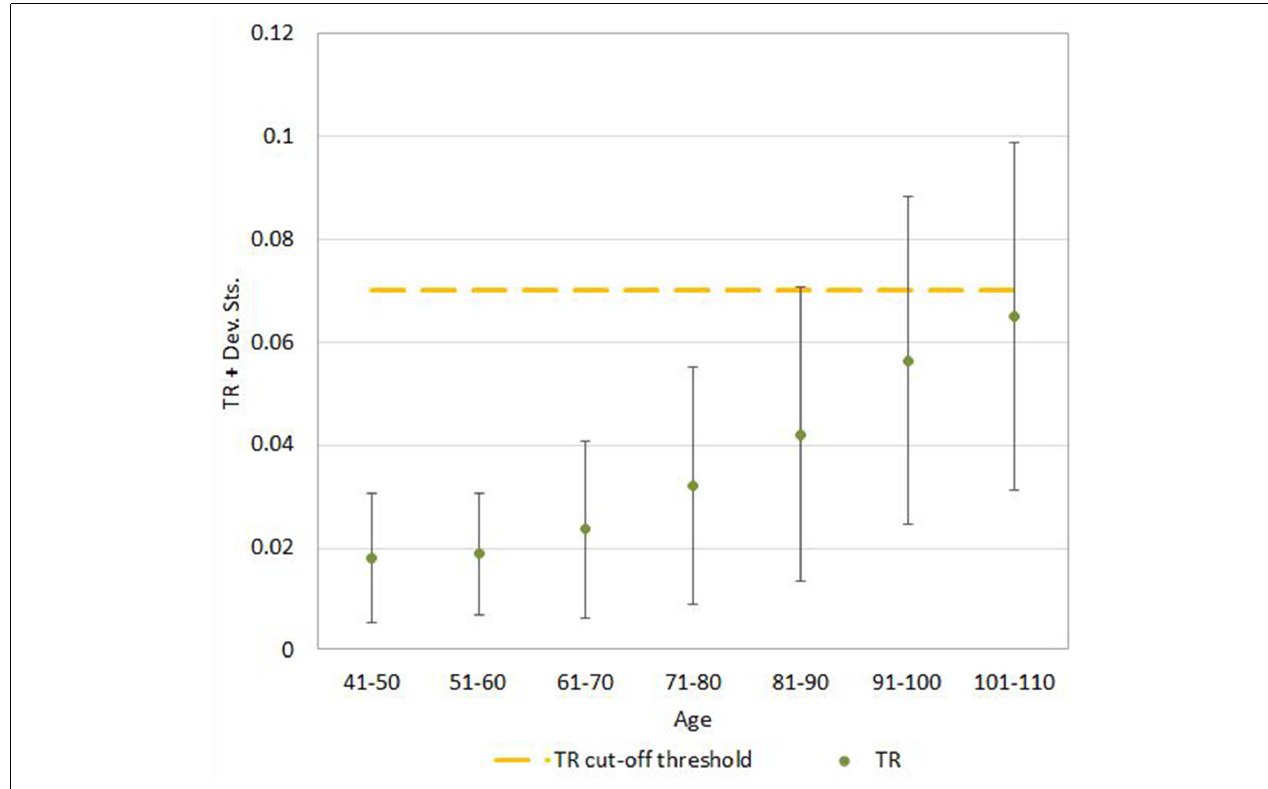
FIGURE 6 | Mean ± SD values for TR neuroimaging measure in each age (10-year) cohorts. Note: the upper part of the bar indicates the 97.5